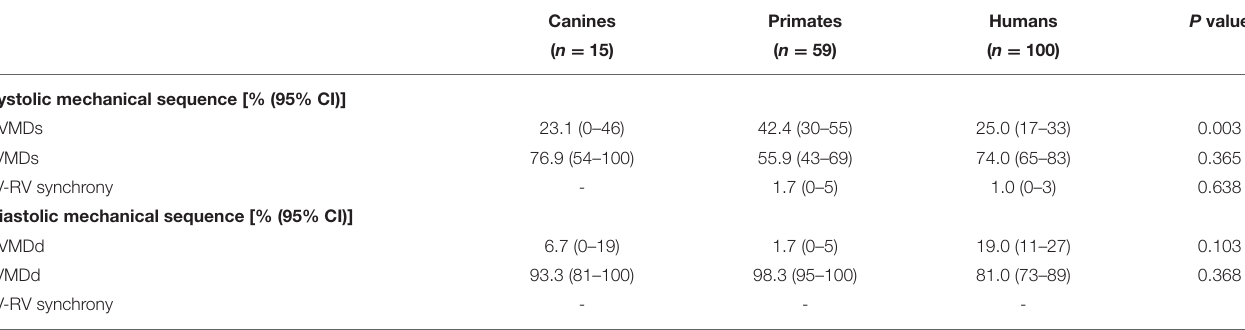
TABLE 4 | Comparative analysis of the ventricular mechanical sequence in healthy hearts.